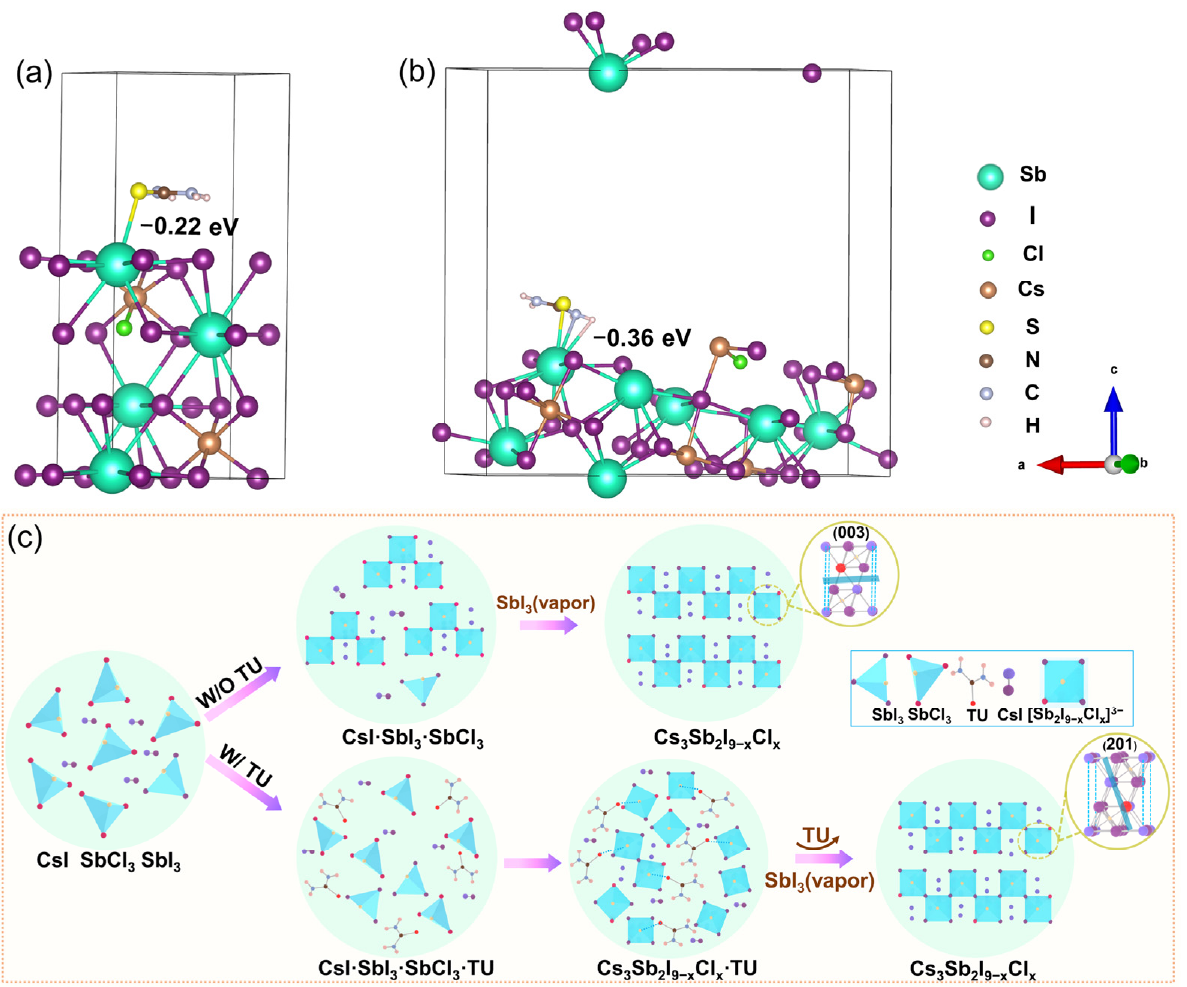
Figure 3. Atomic structure of optimized Cs 3 Sb 2 I 8 Cl ( a ) (001) and ( b ) (201) surface with TU molecule. ( c ) Illustration of the crystallization process of Cs 3 Sb 2 I 9 − x Cl x perovskite film. Figure S8a shows the UV–vis absorption spectrum for Cs 3 Sb 2 I 9 − x Cl x films containing a different content of TU additive. Tauc plots for the assessed band gap value are shown in Figure S8b. Figure S8b shows that the control and TU additive perovskite film